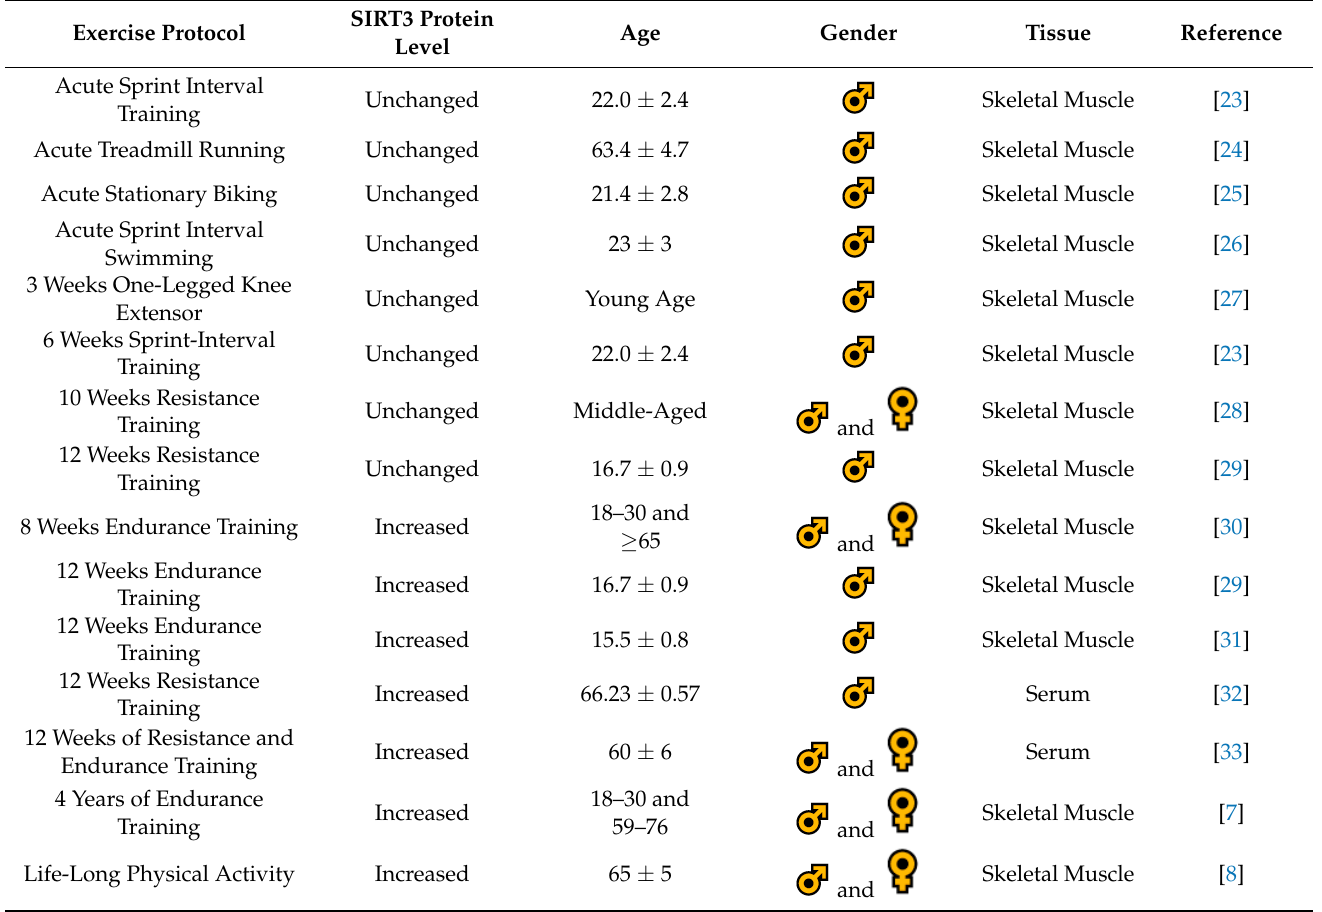
Table 1. The effects of exercises on SIRT3 expression in human studies.